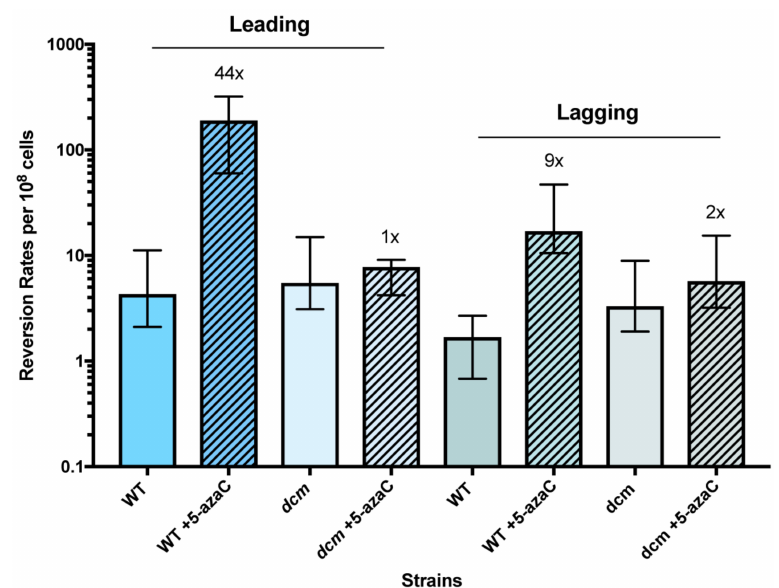
Figure 4. Reversion rates of lacZ QP alleles using leading and lagging strand reporters. Data shows reversion rates per 10 8 cells from at least 6 multiple trials performed in different days of wild-type and dcm null strains. Rates are: 4.3, 5.5, 1.7, and 3.3 respectively. Rates of leading and lagging strand reporters with treatment with 12.5 µ g/mL of 5-azacytidine are 190, 7.8, 20, and 5.7. Fold change comparing rates of reversion with and without exposure of 5-azacytidine is indicated above bars, and are 44, 1, 12 and 2,